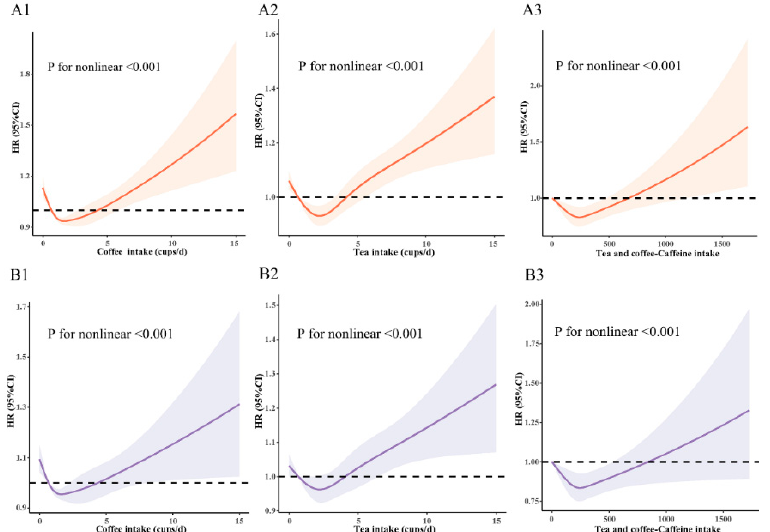
Figure 2. Restricted cubic spline models for the relationship between coffee, tea, and combination caffeine intake from coffee and tea with adult-onset asthma. ( A ) The restricted cubic spline model is unadjusted: ( A1 ) Coffee and adult-onset asthma; ( A2 ) Tea and adult-onset asthma; ( A3 ) combination caffeine intake from coffee and tea and adult-onset asthma. ( B ) Restricted cubic spline model is adjusted by age, gender, race, BMI, smoking status, education, and Townsend Index and adjusted for coffee in tea analysis or for tea in coffee analysis: ( B1 ) Coffee and adult-onset asthma, ( B2 ) Tea and adult-onset asthma, ( B3 ) combination caffeine intake from coffee and tea and adult-onset asthma. The 95% CIs of the adjusted HRs are represented by the shaded area. BMI, body mass index; HR: hazard ratio; CI, confidence interval.